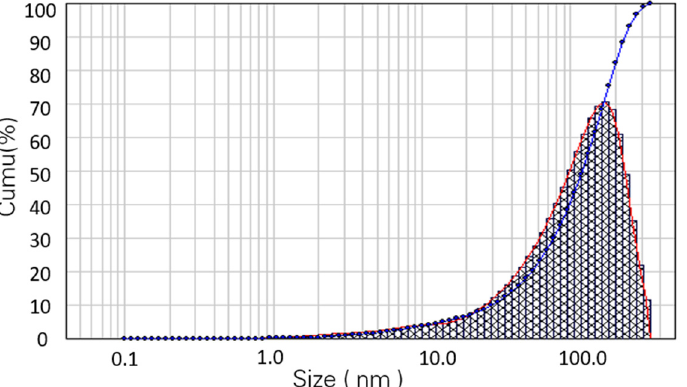
Figure 1. Field-emission scanning electron microscopy (FE-SEM) and high-resolution transmission electron microscopy (HR-TEM) image of the nano-SiO 2 sphere. Table 1. The D 10 , D 50 , D 90 of nano-SiO 2 .